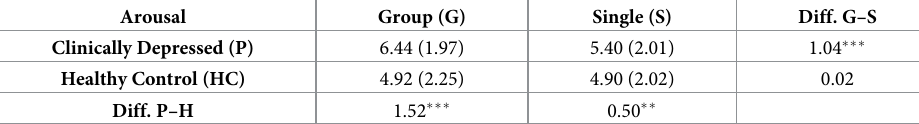
Table 15. Arousal before feedback by